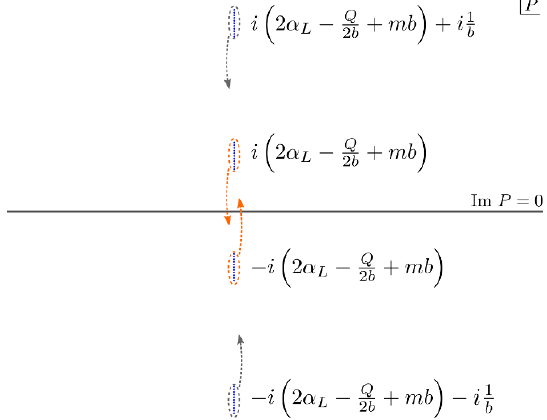
Figure 1 . Representation of the poles (5.8) of the DOZZ coe(cid:14)cients in the complex P -plane. The poles come in towers, represented by the dots inside the dashed ellipses, where elements are labeled by non-negative integers m and spaced by b . The arrows indicate the direction of the analytic continuation as one continues (cid:11) L from (cid:11) L > Q= 4 (cid:25) 1 = 4 b to the regime (cid:11) L < Q= 4. In the semiclassical limit b ! 0, only the two towers of poles with n = 0 in (5.8) cross the real P